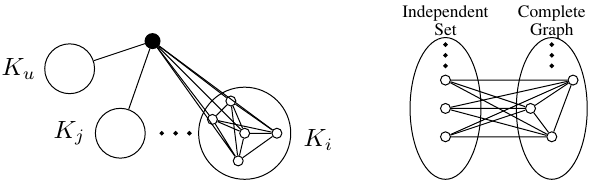
Fig. 2: Examples of graphs with unbounded neighborhood diversity and bounded twin-cover (left), and vice-versa (right). The left graph consists of a set of independent and disjoint cliques, all adjacent to a single vertex. The right graph is a complete bipartite graph where one side of the bipartition is a clique and the other is an independent